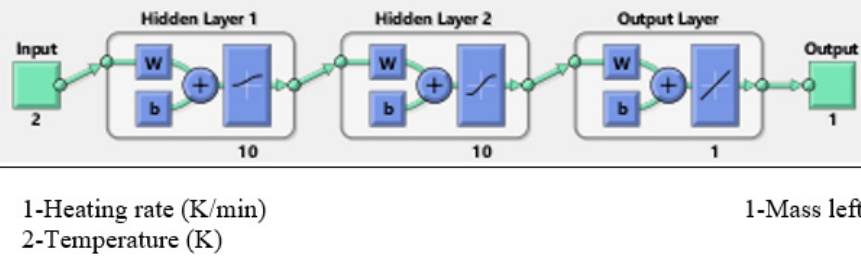
Figure 3. Topology of the selected AN7-A and AN7-B network.